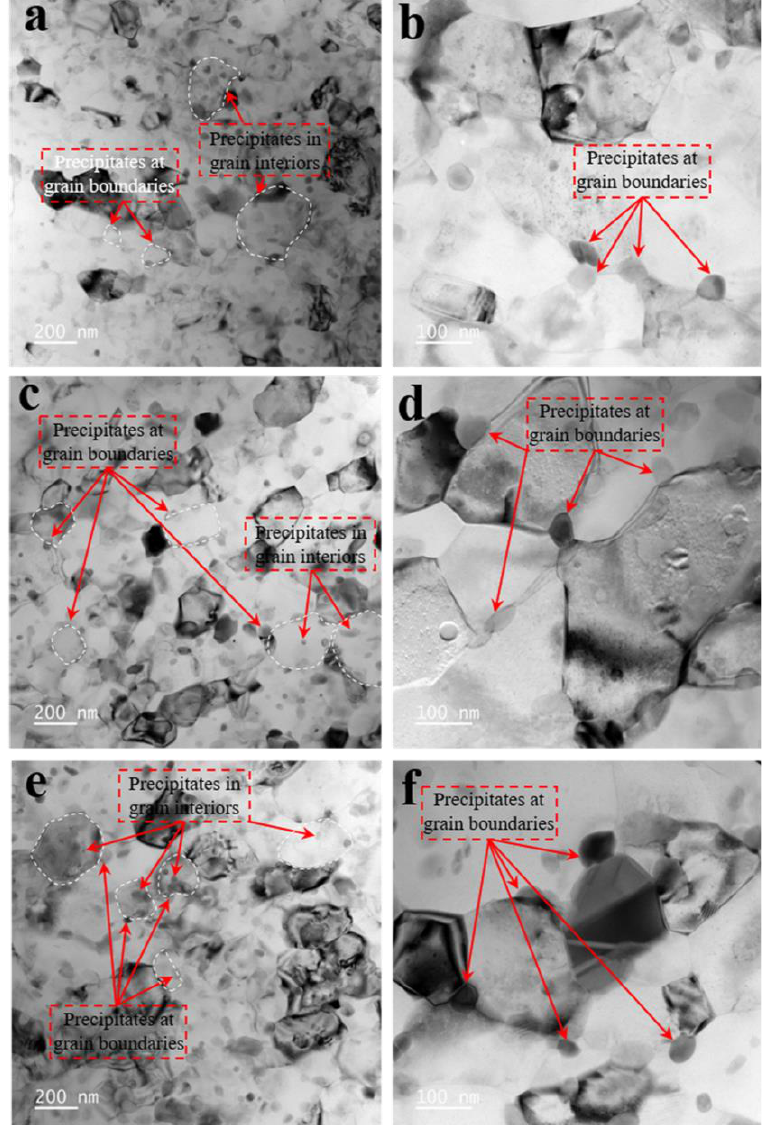
Figure 8. Bright-field images of the evolution of the precipitates with SMGT alloy aged for ( a , b ) 6 min, ( c , d ) 27 min, and ( e , f ) 60 min at 210 °C.